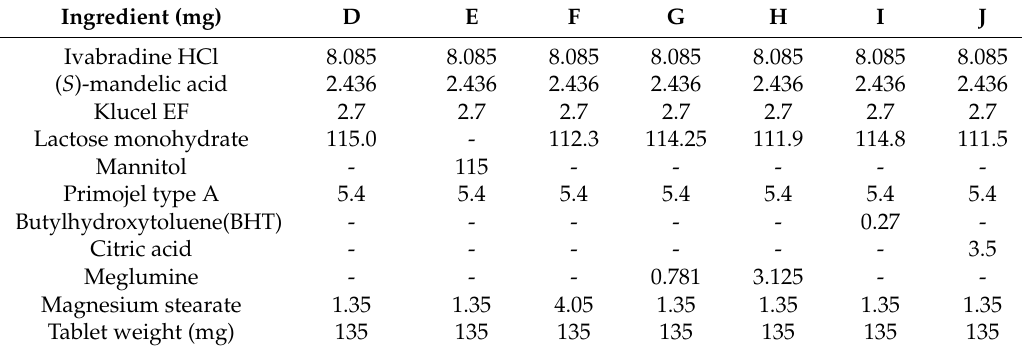
Table 3. The composition of the mixtures D–J with co-crystal formed in